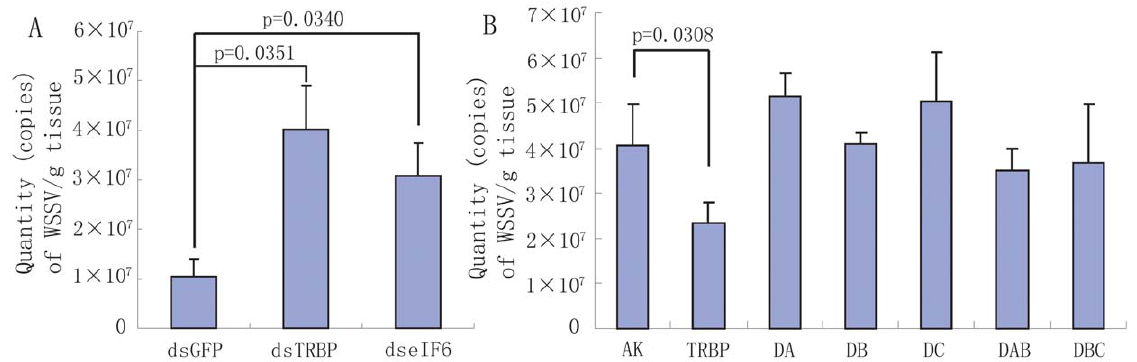
Figure 7. Mj -TRBP and Mj -eIF6 involvement in antiviral immunity. A: The proliferation of WSSV was enhanced by silencing Mj -TRBP and Mj - eIF6. B: Injection of recombinant TRBP inhibited the proliferation of WSSV, whereas injection of TRBP fragments did not, suggesting the integrity of TRBP is required for its antiviral function. Figure S1 Multiple alignments of Fc -TRBP1 (GenBank no. EU679001) with Mj -TRBP1-3.